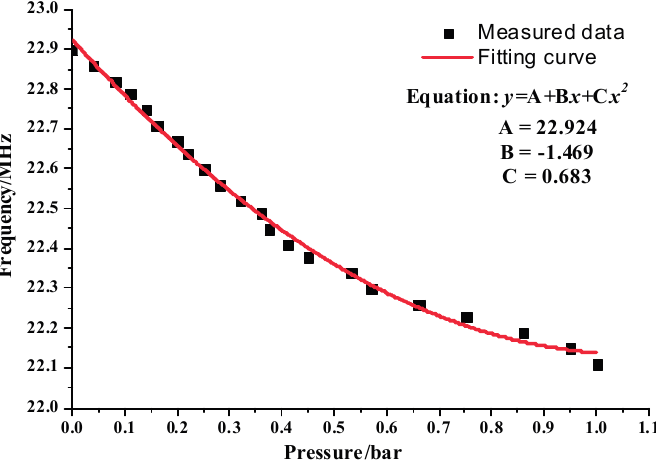
Figure 8. Measured frequency versus pressure.